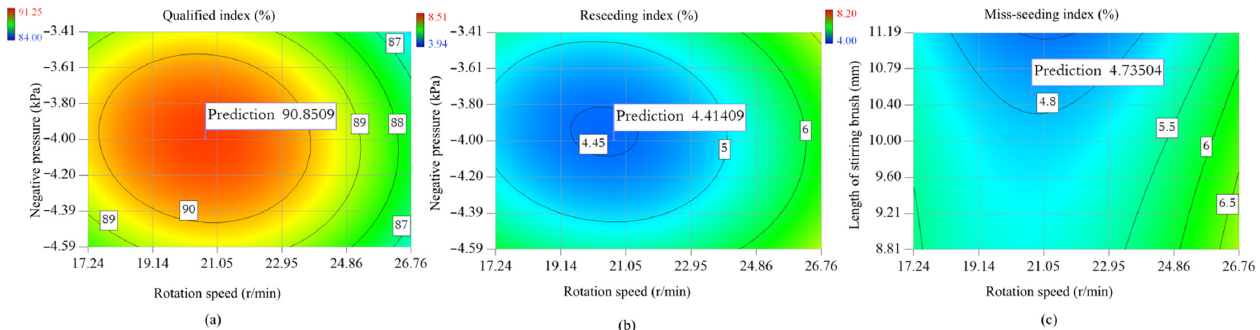
Figure 8. Optimized regional contour map: ( a ) contour map of the optimized area of negative pressure and rotation speed for pass index; ( b ) contour map of the optimized area of negative pressure and rotation speed for reseed index; ( c ) contour map of the optimized area of stirring brush length and rotation speed for missed index.